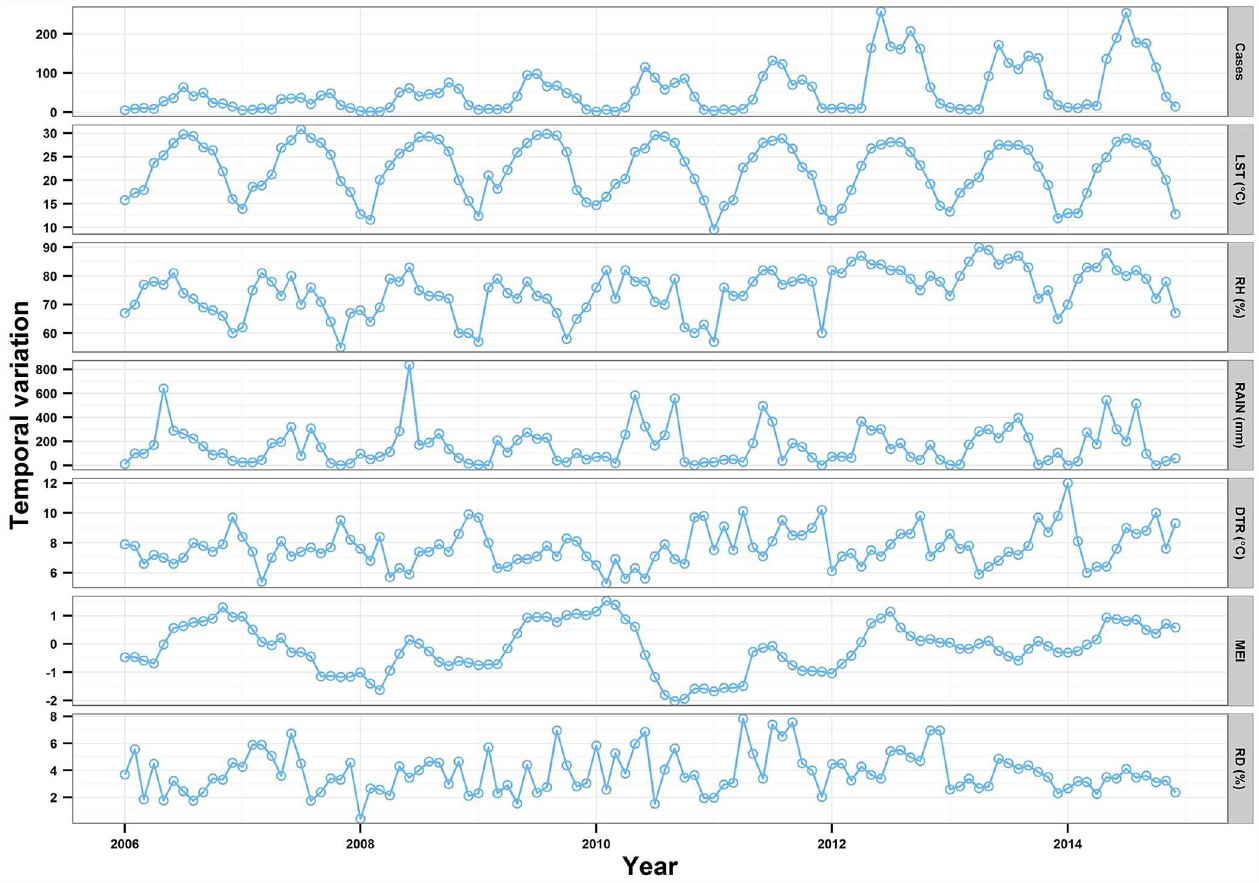
Fig 2. Temporal variation in the number of scrub typhus cases,climate variables, and rodent density in Guangzhou, Southern China, 2006–2014.